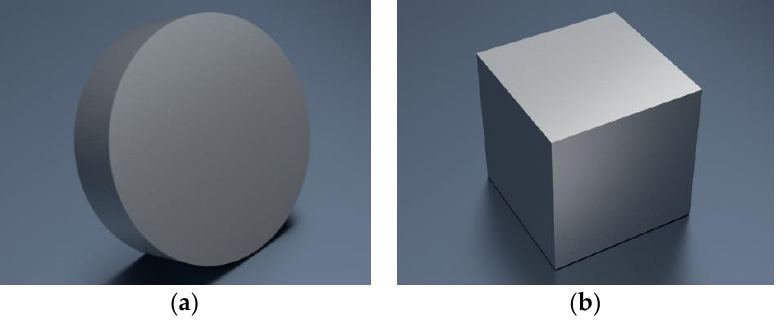
Figure 2. Full solids constituting a reference point for 3D modeling: ( a ) The cellular lattice with TPMS architecture; ( b ) Bulk specimen.